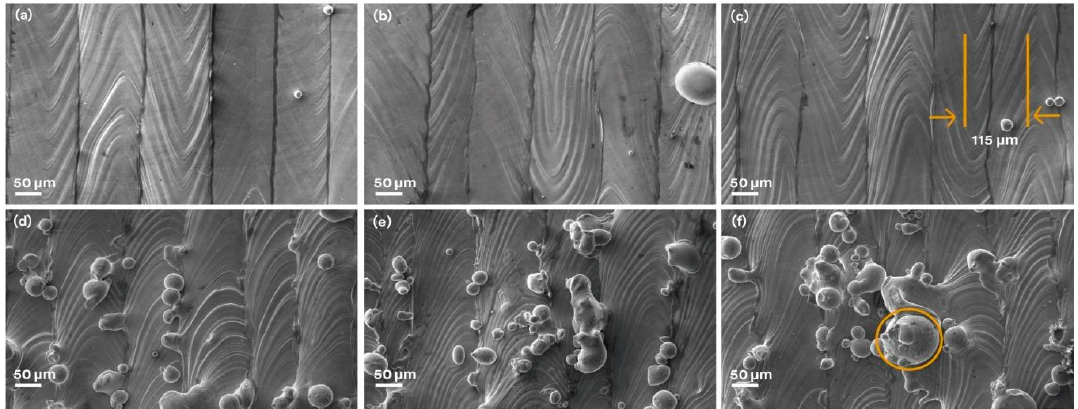
Figure 4. Scanning electron microscope (SEM) micrographs of the samples at 90°: ( a ) chessboard, ( b ) meander, and ( c ) stripes/hatching distance of 115 μ m; and at 60°: ( d ) chessboard, ( e ) meander, and ( f ) stripes; the circle shows semi-molten particles which create roughness on the sintered surface.